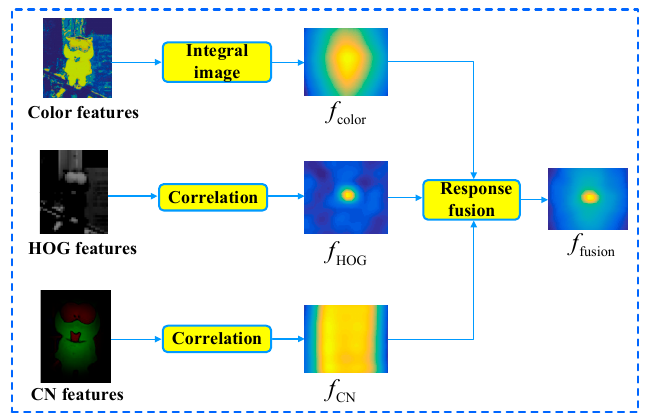
Figure 4. The response fusion of the lemming sequence.